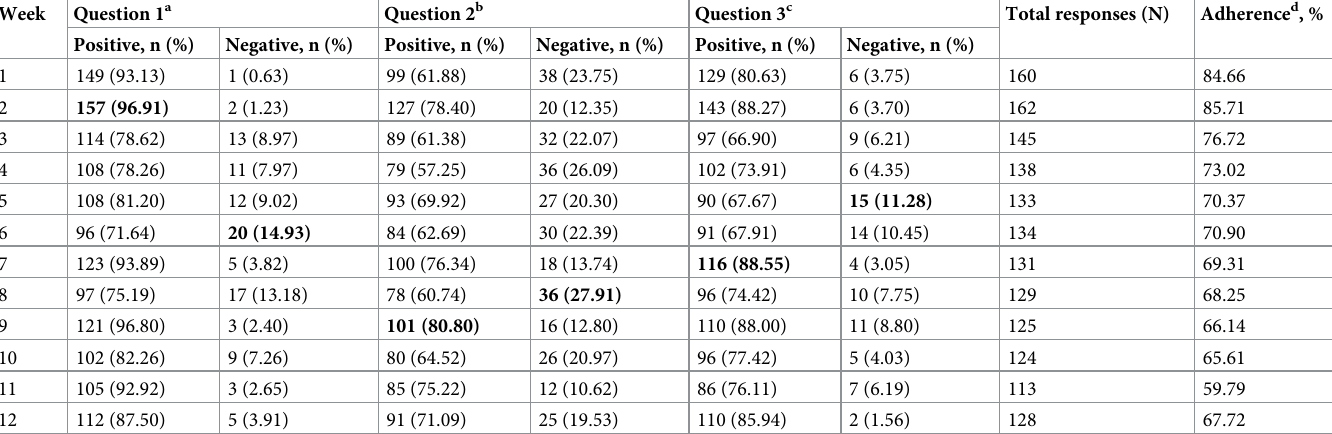
Table 3. Weekly evaluations of the social media content shared within the #chatsafe